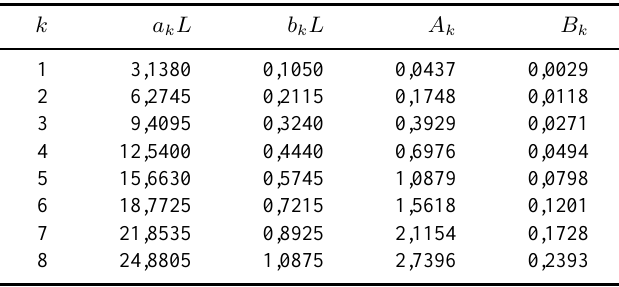
Table 2. The discrete values q k L , ~ (cid:11) k